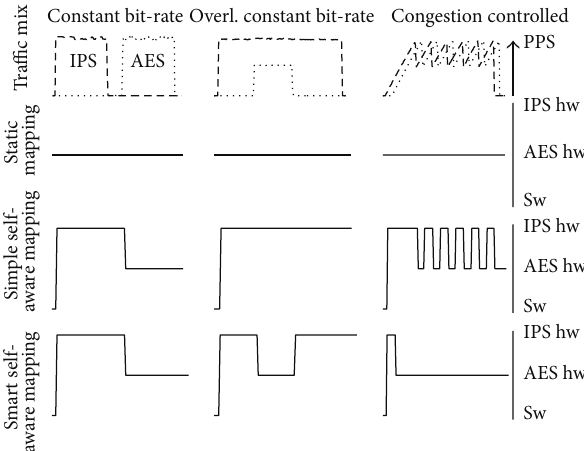
Figure 9: Traffic mixes and resulting hardware/software mappings for the three mapping algorithms over time. The static algorithm always puts the AES block in hardware. The dynamic algorithms start with no functional block mapped to hardware but adapt the mapping to the